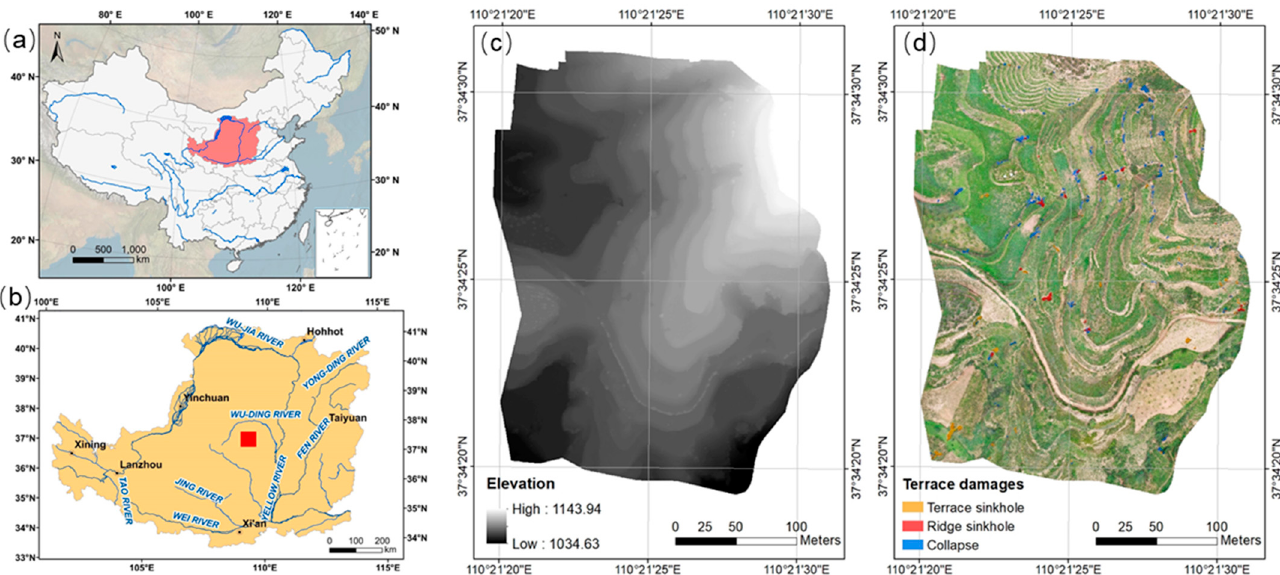
Figure 2. Study area and data: ( a , b ) Locations of the Loess Plateau, China and the study area; ( c ) DSM of the study area obtained from UAV photogrammetry; ( d ) Image obtained from UAV photogrammetry with reference polygons of terrace damages by artificial interpretation.